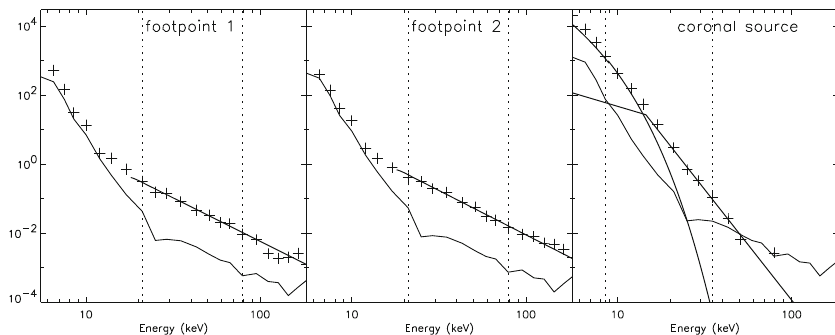
Fig. 11 Spectra of the three sources shown in Fig. 10 as observed by RHESSI at peak time. Left and middle spectra of footpoints. A power-law was fitted in energy between the dotted lines . Right spectrum of the coronal source. A power-law and a thermal population was fit between the dashed lines . Image reproduced with permission from Battaglia and Benz (2006), copyright by